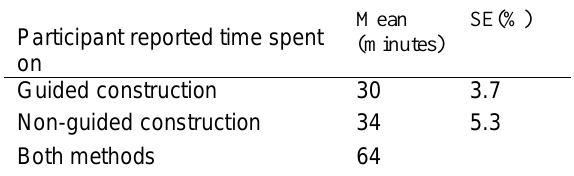
Table 3: Post-Study Survey Questionnaire - Usability Table 4: Participants’ answers to th e time they spent